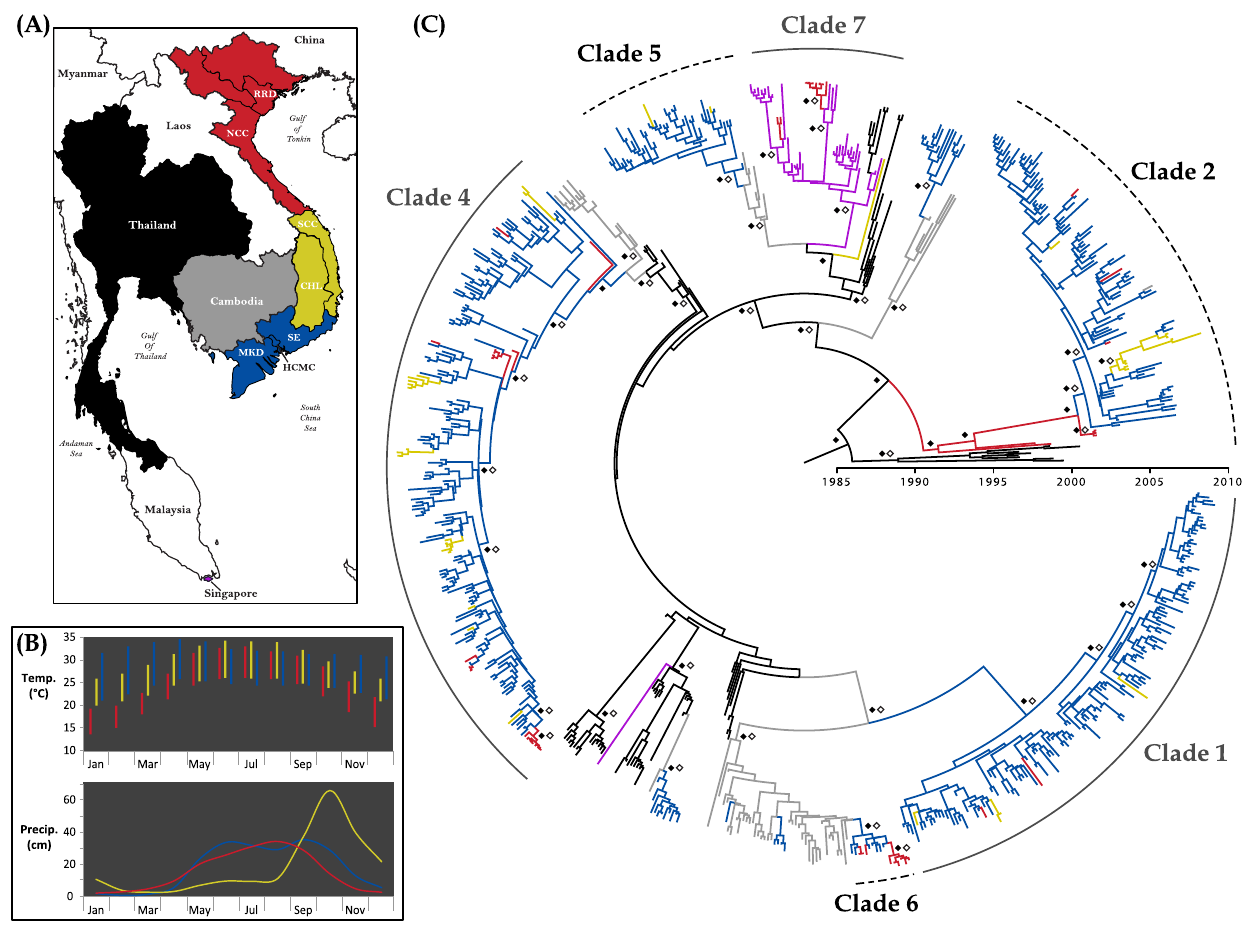
Figure 1. Regional phylogeography among 705 DENV-1 genotype 1 sequences isolated in Southeast Asia from 1998 to 2009. A) Map of Southeast Asia. B) Monthly averages of climate factors in the three primary regions of Viet Nam (mean maximum and mean minimum monthly temperatures, mean precipitation). Data for the largest city in each region (Hanoi, Danang, Ho Chi Minh City) were obtained from the World Meteorological Organization (http://worldweather.wmo.int/) and are colored as in A. C) Maximum clade credibility (MCC) tree showing phylogeographic relationships among Southeast Asian DENV-1 E gene sequences. Branch colors correspond to locations indicated in the map (Singapore shown in purple). Closed diamonds indicate posterior probability support $ 0.85. Open diamonds indicate ancestral location state probability $ 0.85.